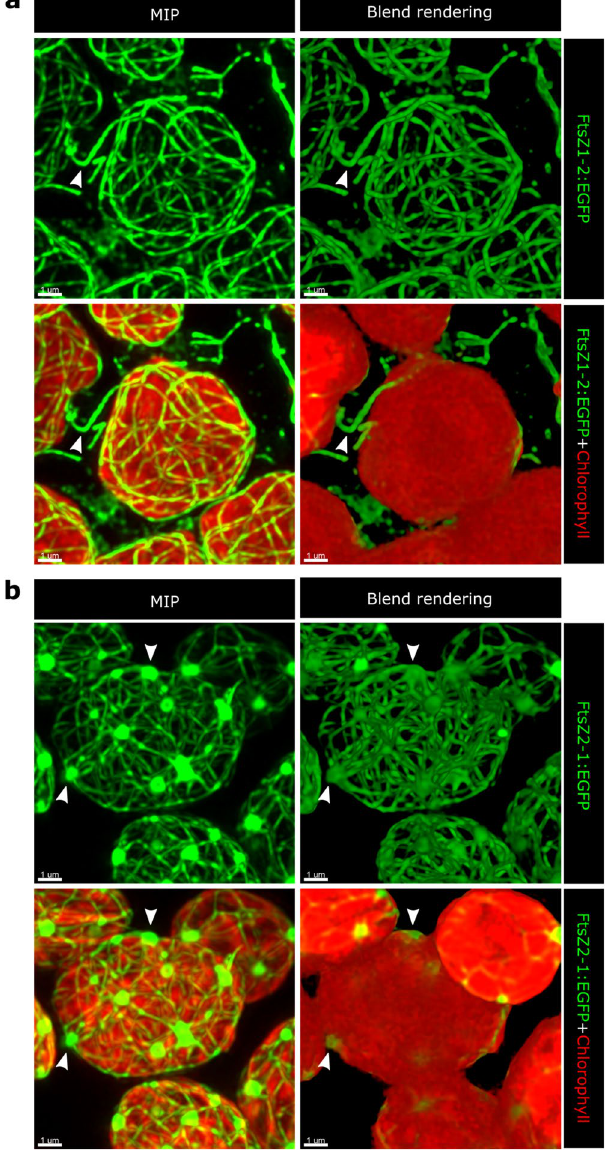
Figure 1. Examples of relatively complex networks and the corresponding chloroplasts hosting them are illustrated for each isoform. Confocal image z-stacks were deconvolved via Huygens software (Scientific Volume Imaging). For illustration, maximum intensity projection (MIP) and volume reconstruction (blend rendering) were applied to the deconvolved images via the IMARIS software (Bitplane). ( a ) FtsZ1-2 networks show uniform size for segments and nodes. A common feature of FtsZ1-2 networks is the presence of extraplastidic filaments which sometimes connect multiple chloroplasts of a cell (arrowheads). ( b ) FtsZ2-1 networks show detectable heterogeneity in node size with the meganodes being noticeably larger. The meganodes are usually located at the chloroplast surface (arrowheads). Unlike FtsZ1-2, in the networks of FtsZ2-1, no inter-plastidic connections are observed and occurrences of the extraplastidic filaments in general are very